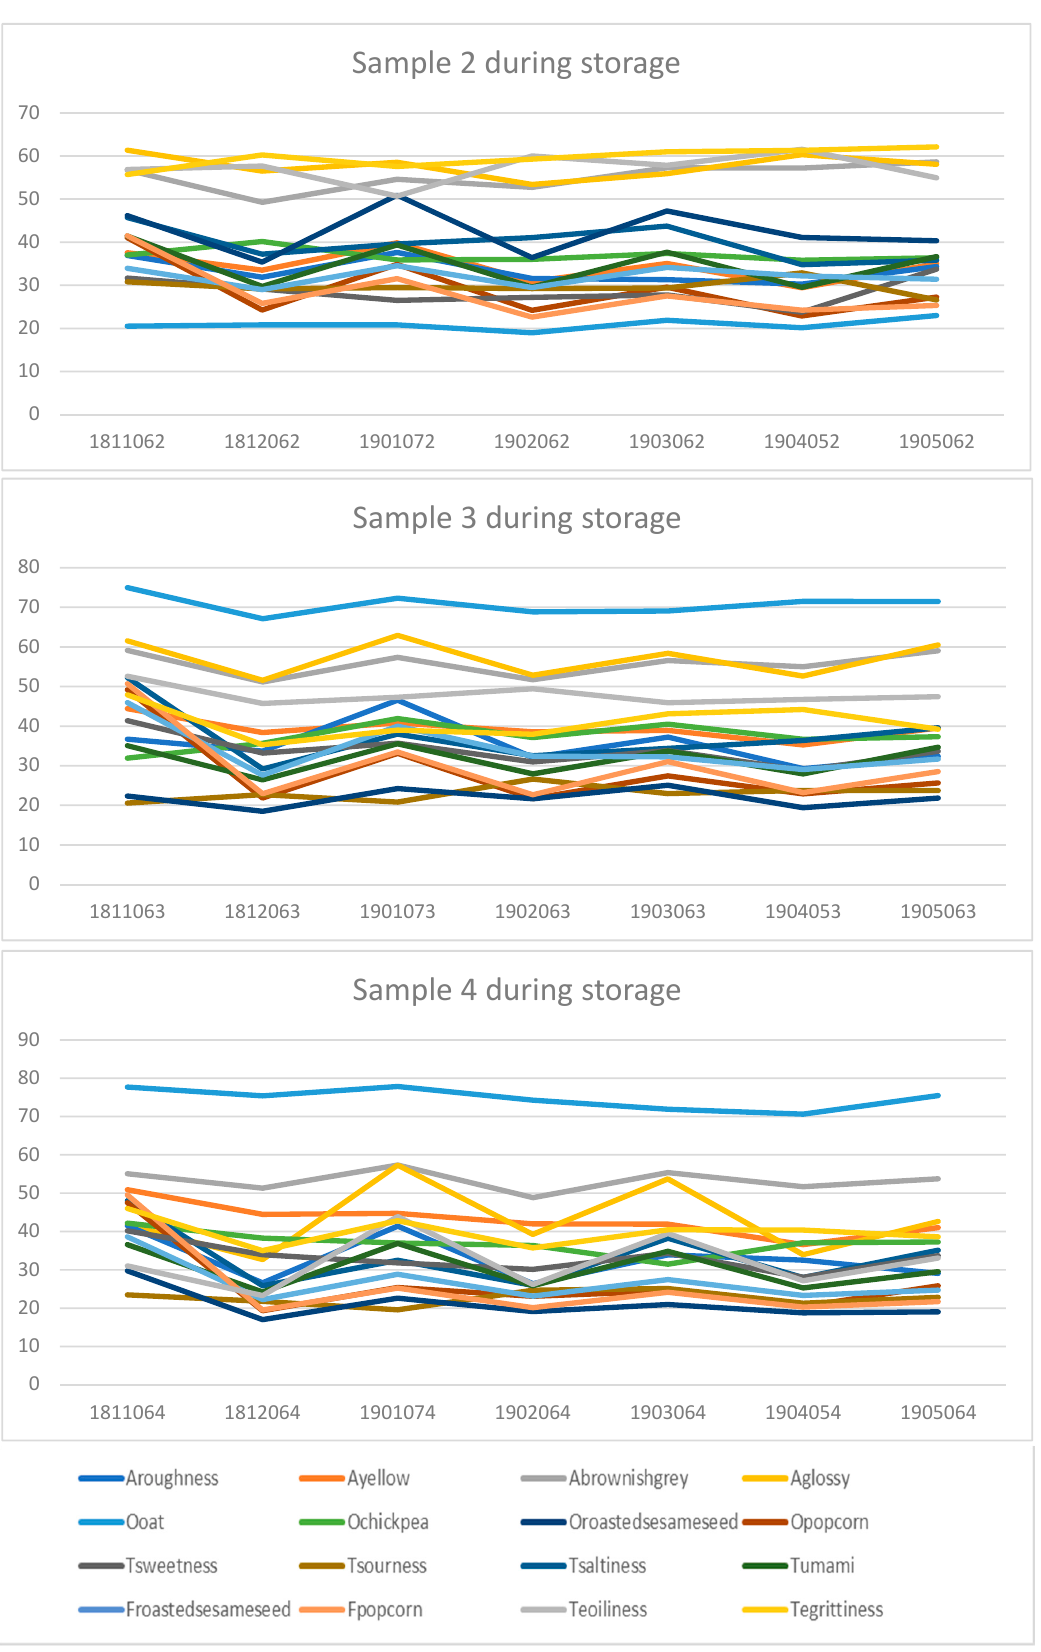
Figure 3. The perceived sensory attributes of all four samples when fresh and after 1, 2, 3, 4, 5 and 6 months of storage.